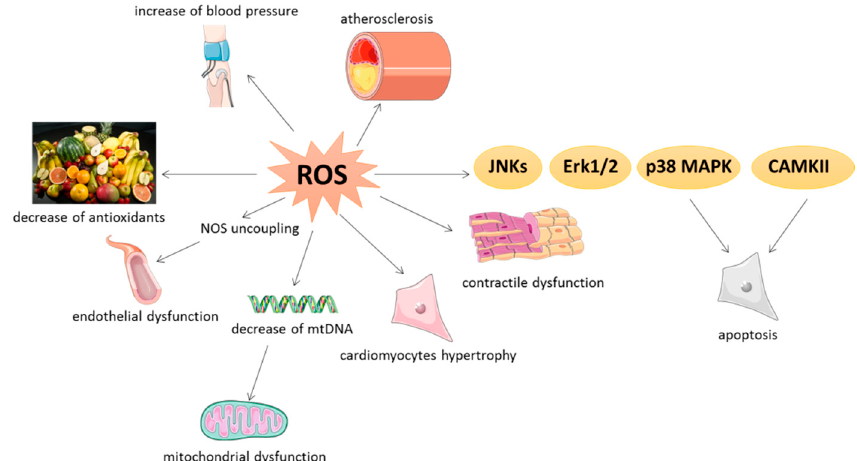
Figure 4. Pathological roles of oxidative stress in cardiovascular tissues. ROS: reactive oxygen species; NOS: nitric oxide synthase; mtDNA: mitochondrial DNA; JNK: c-Jun N-terminal kinase; Erk1/2: Extracellular signal-regulated kinases; p38 MAPK: p38 mitogen-activated protein kinase; CAMKII: Ca/calmodulin-dependent kinase II.